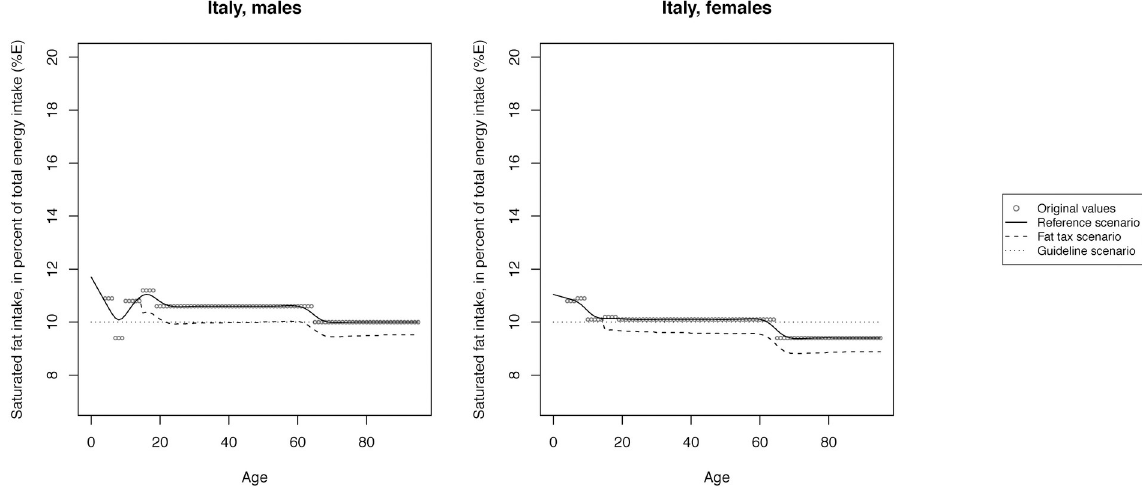
Fig 3. Mean saturated fat intake across reference, fat tax and guideline scenario in Italy.